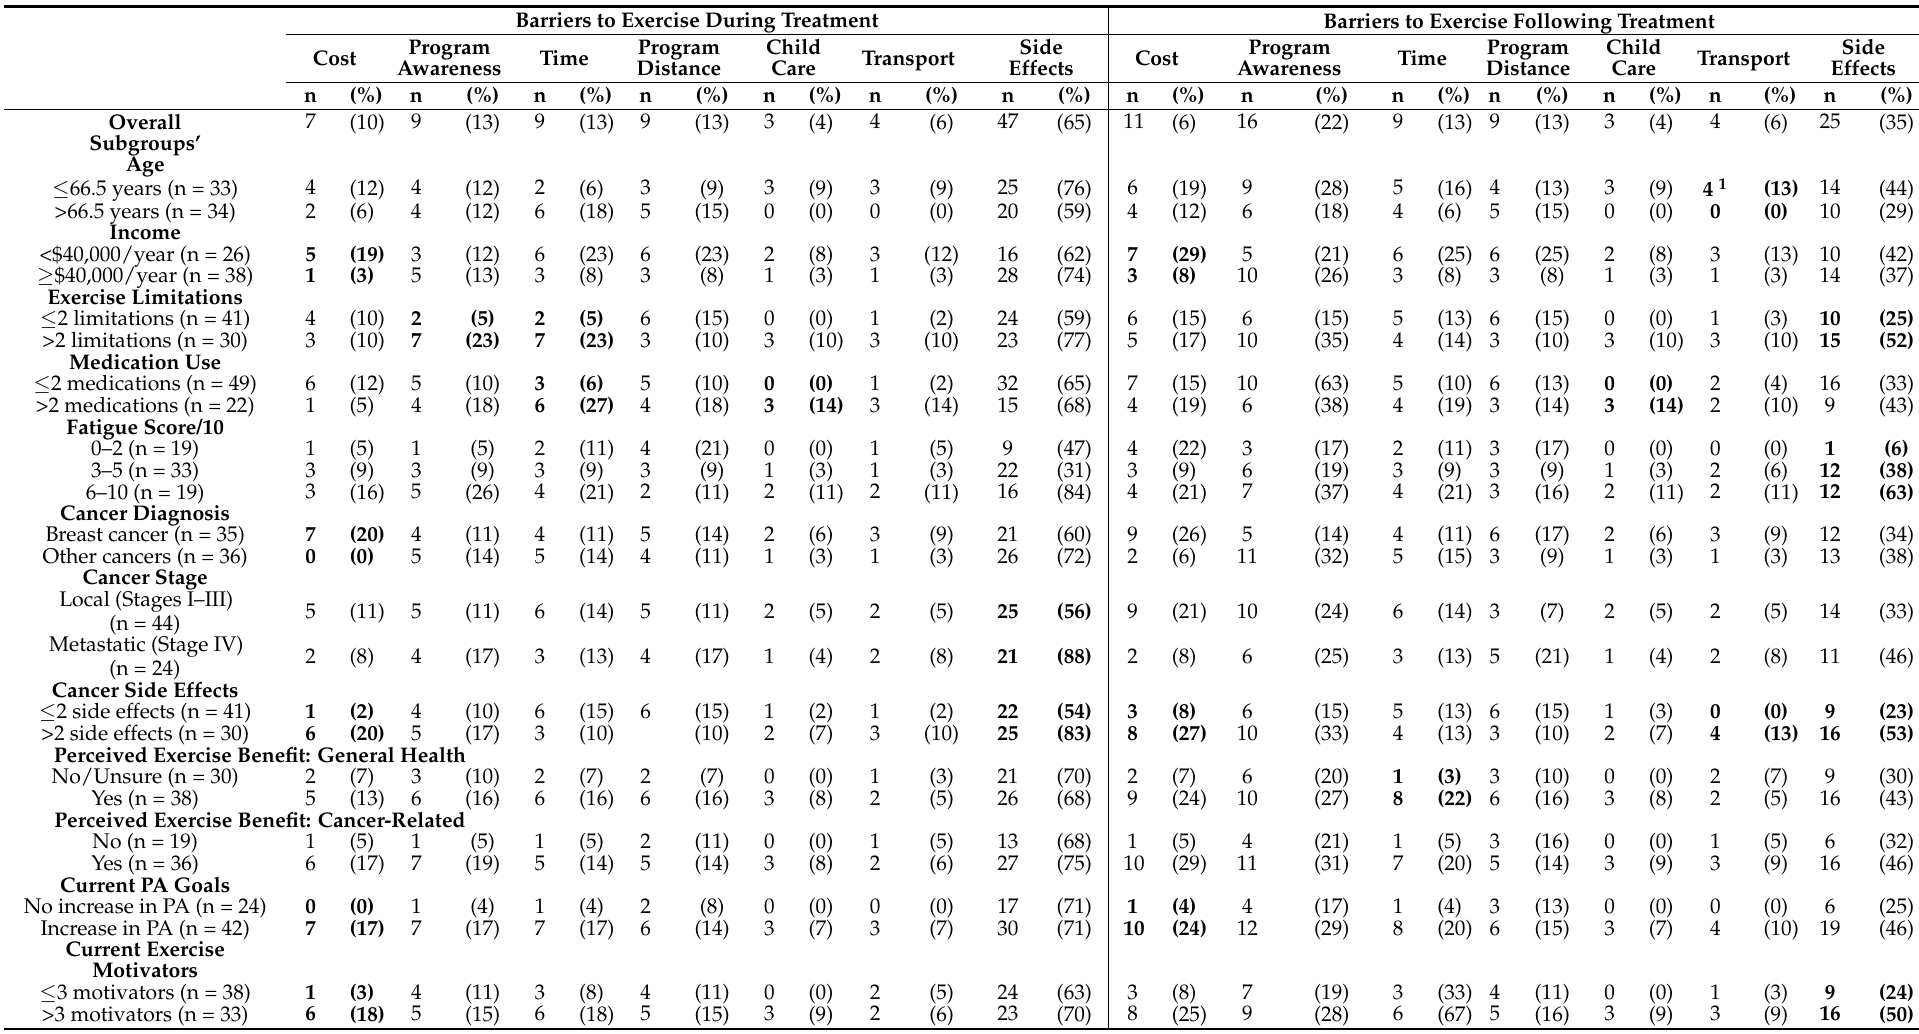
Table 4. Reported barriers to exercise during and following treatment for rural cancer